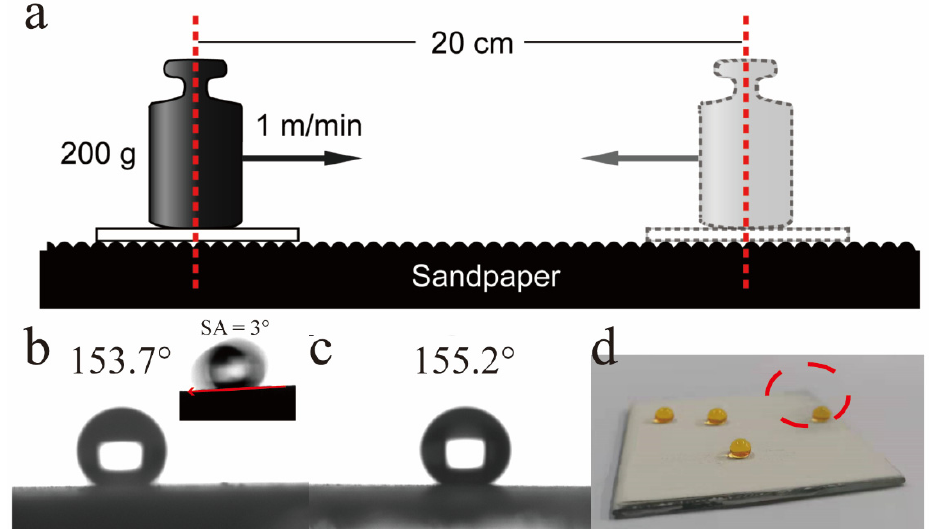
Figure 7. The wettability of the GP-SHCs after repeated rubbing: ( a ) the schematic diagram of wear resistance test, ( b )the CA of GP-SHC surfaces after one cycle, ( c ) the CA of GP-SHC after two cycles, ( d ) the actual photo of GP-SHC after two cycles.